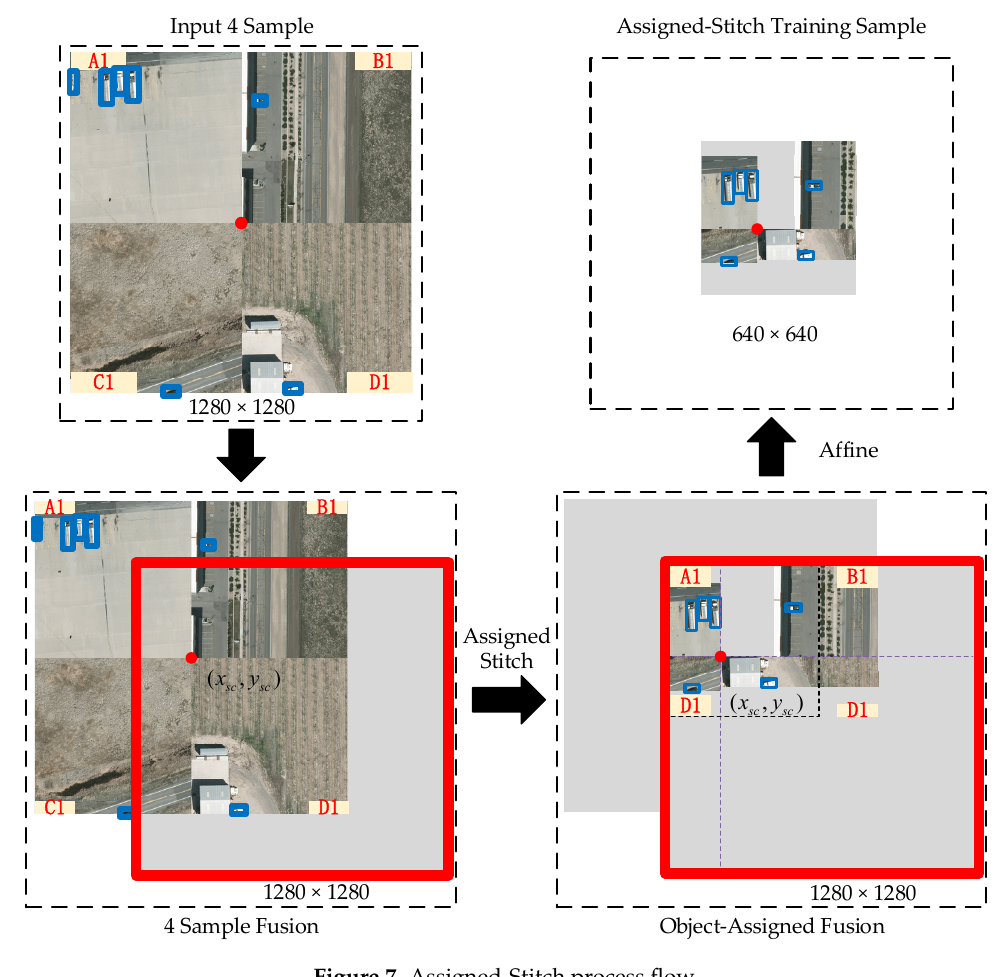
Figure 7. Assigned-Stitch process flow.